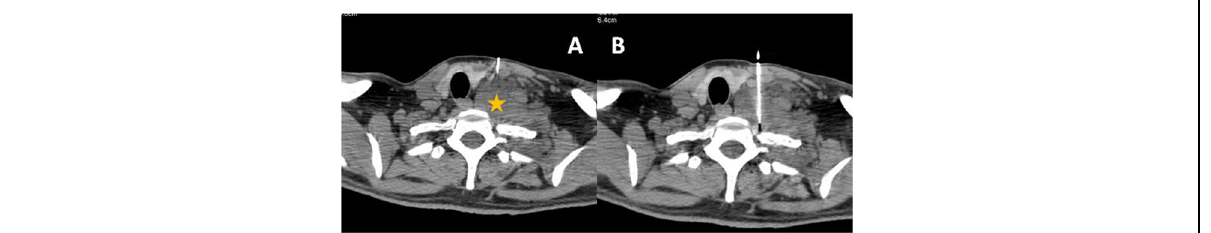
Fig. 13 Hydrodissection approach for stellate ganglion neurolysis. Axial CT section showing the a injection of saline (star). b Needle tip passing through the saline into the stellate